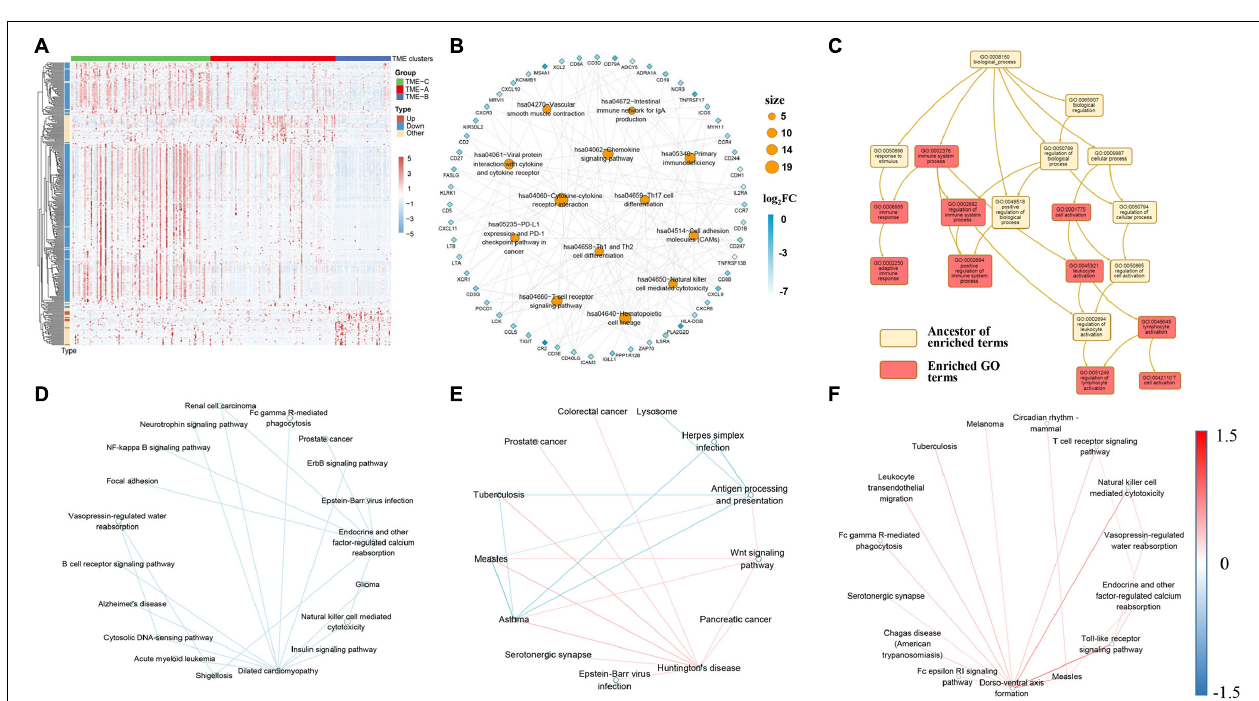
FIGURE 3 | (A) The Kaplan–Meier curves of overall survival based on three TME groups. Different solid color denotes different group. The dashed line indicates a 95% confidence interval. (B) The Leiomyosarcoma samples in the three TME groups had significant differences in survival. (C) The Kaplan–Meier curves of overall survival based on Dedifferentiated liposarcoma samples.